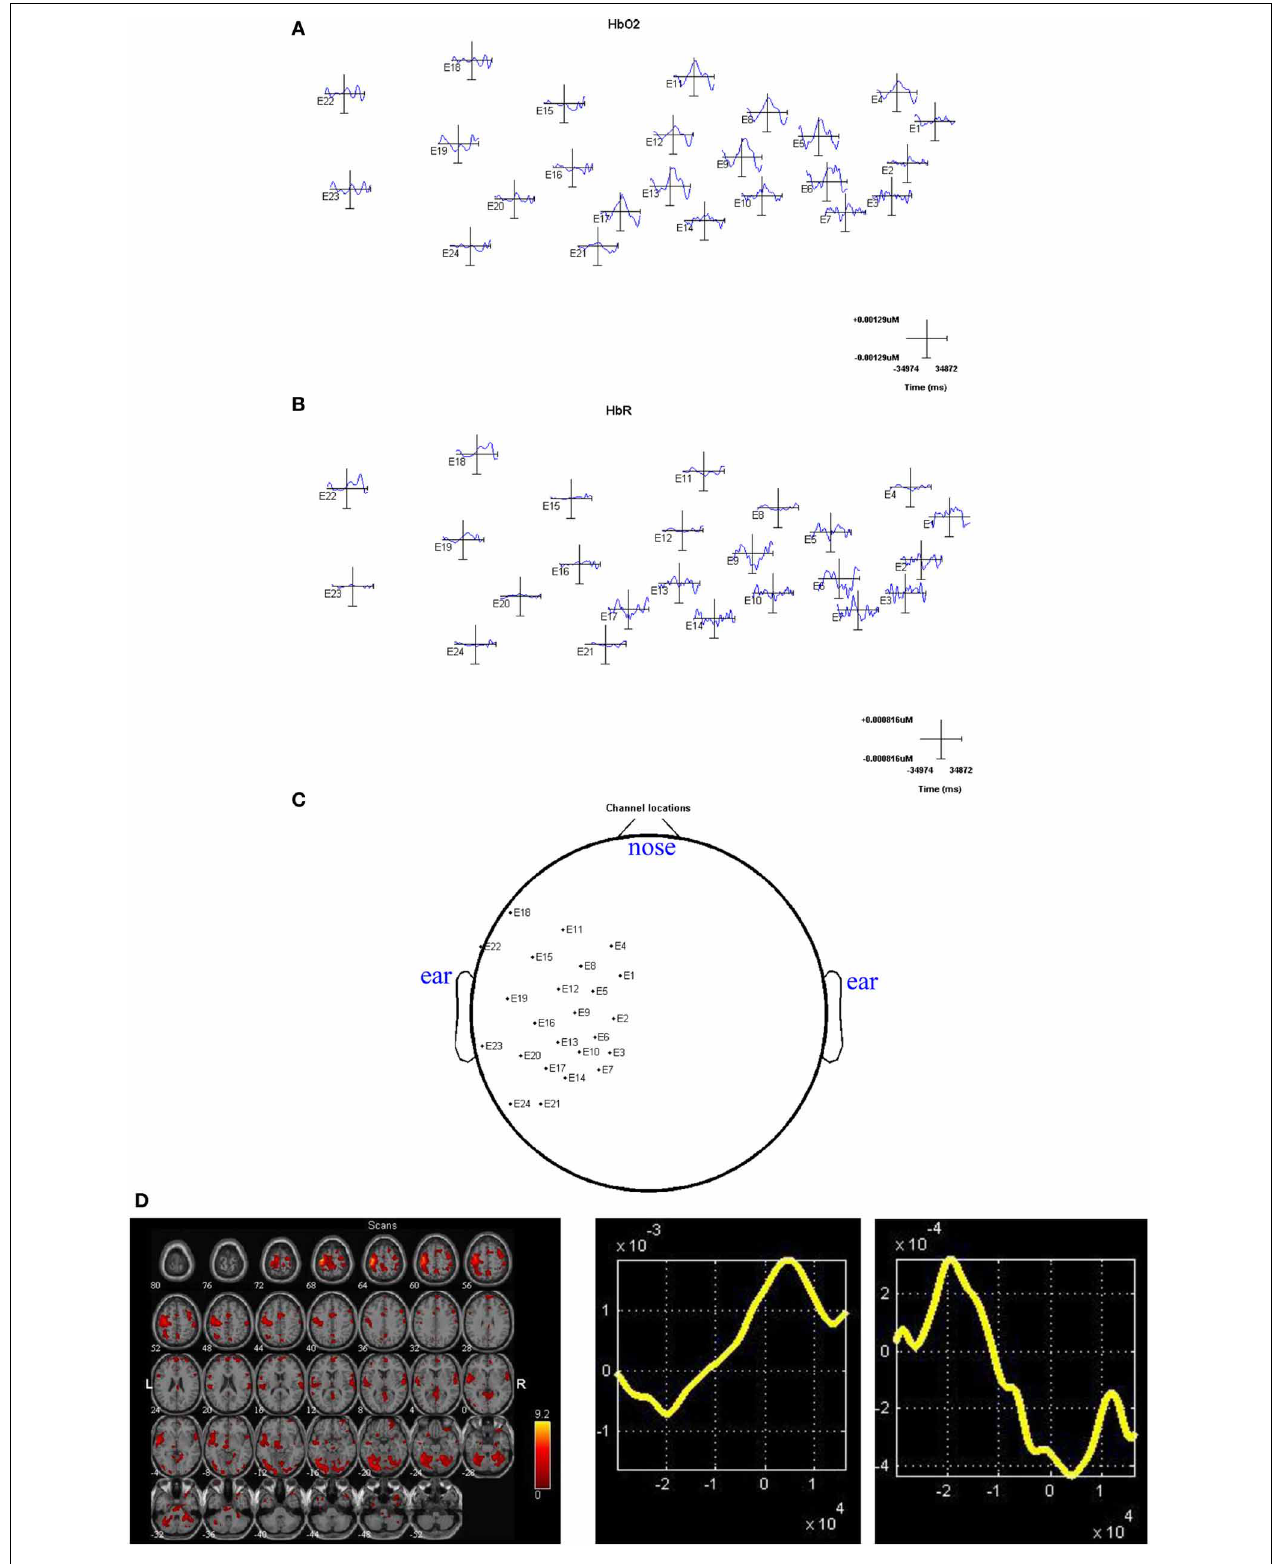
(cid:2) HbO 2 results (middle) and (cid:2) HbR results(right side). The axes (bottom middle and bottom right) illustrate the time scale, in ms, whereas the scale for the middle and right columns records chromophore concentrations in μ